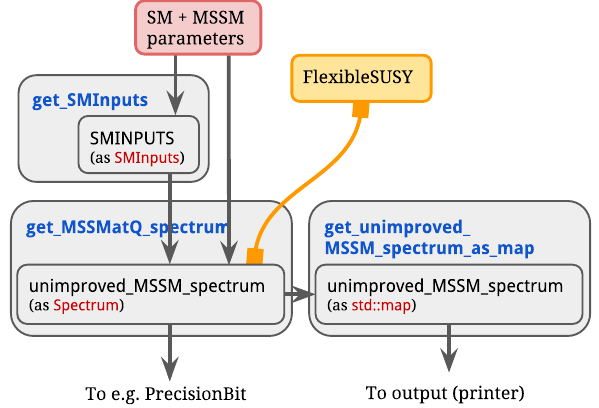
Fig. 2 A typical flow of information through SpecBit , using MSSM module functions as examples. First, model parameters (red box) are obtained from the GAMBIT Core. Some of these are used to construct Standard Model input information for the spectrum generation ( SMINPUTS , upper grey box), while MSSM parameters are passed directly to the spectrum builder function ( get_MSSMatQ_spectrum ,lowerleftgreybox).Thisfunctioncon- structs a Spectrum object, which wraps information obtained from FlexibleSUSY (yellow box), and passes it on to other parts of GAM- BIT . In addition, the Spectrum object is translated into a C ++ map (lower right grey box), which can be parsed by the GAMBIT printer system and written to